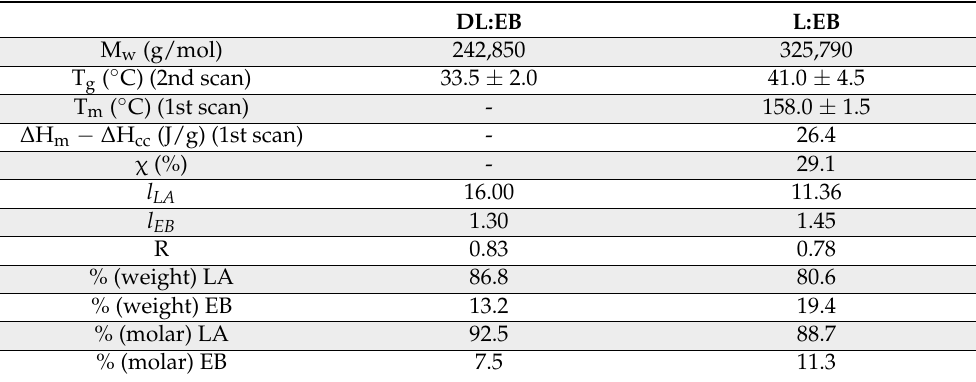
Table 1. Characterization of the synthesized copolymers.